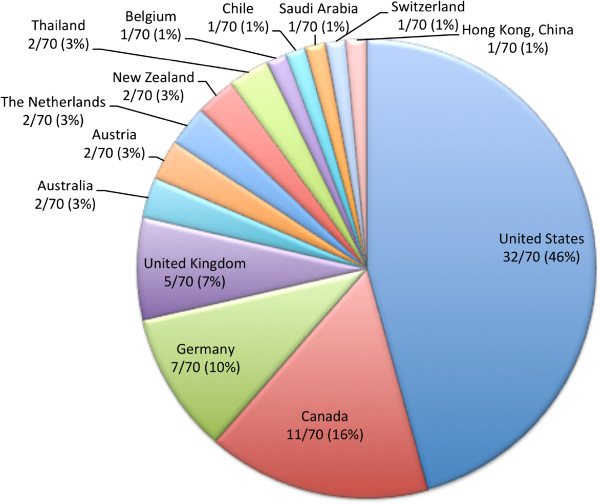
 Respondents’ country of origin. The majority of respondents are from North America: United States (46%) and Canada (16%).